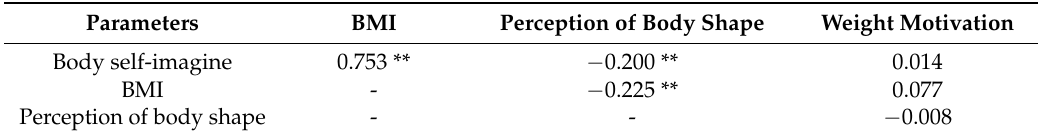
Table 4. The statistical correlation between BMI, body self-imagine, perception of body shape, and weight